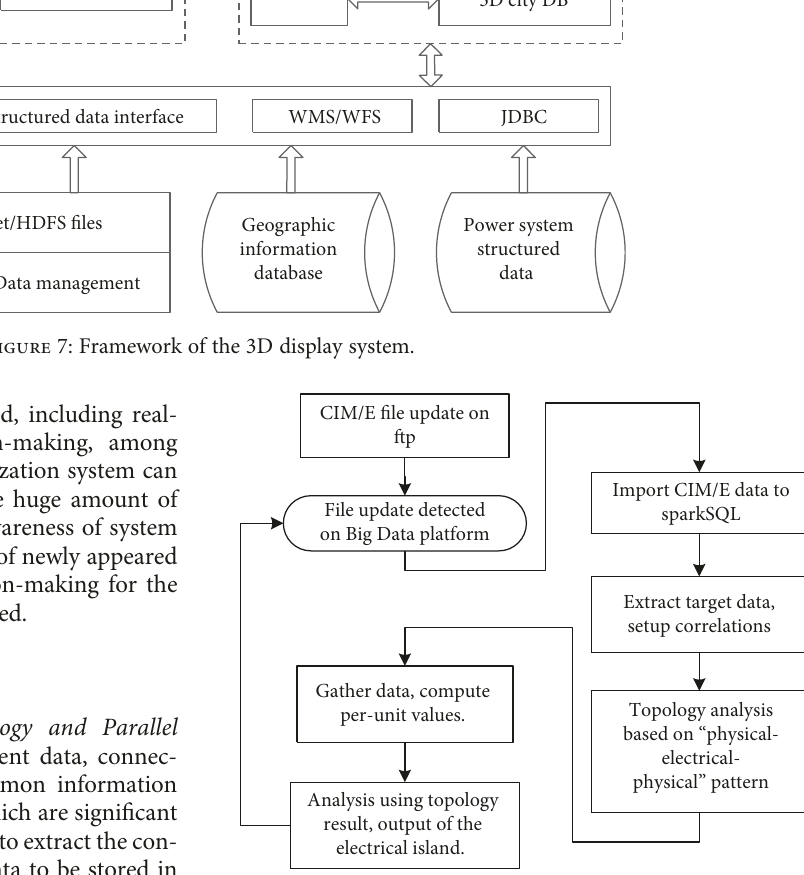
Figure 8: Fast-speed analysis fl owchart for CIM fi